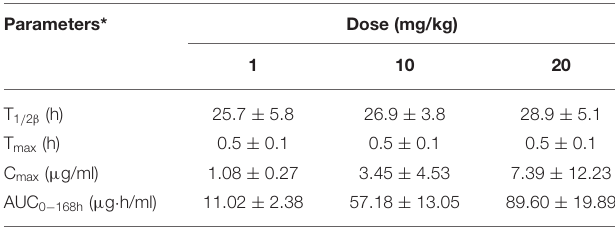
TABLE 1 | Pharmacokinetic parameters of tulathromycin in serum following single dose intramuscular administration at 1, 10, or 20 mg/kg in H. parasuis infected guinea pigs (mean ± SD, n =